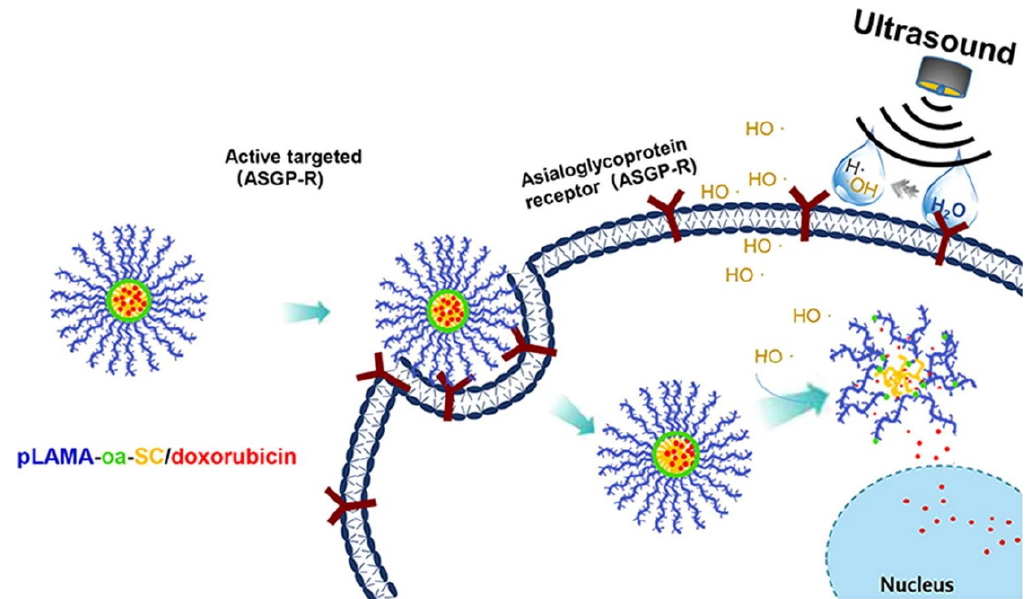
Figure 15. Schematic illustration of ultrasound-labile motif and hepatocellular carcinoma-targeted drug delivery system (pLAMA-oa-SC/Doxorubicin self-assembled nanostructures) for ultrasound-specified augmented cytotoxic potency to hepatocellular carcinoma (Reprinted with permission from Ref. [80]. 2019, Jingyun Wang).